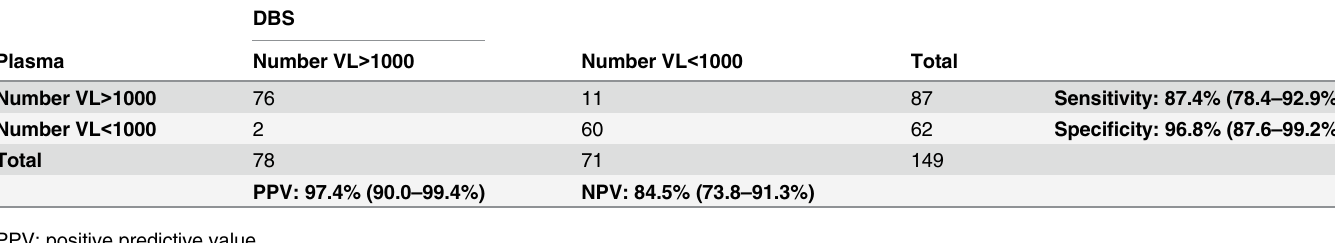
Table 2. Qualitative agreement between plasma and DBS viral